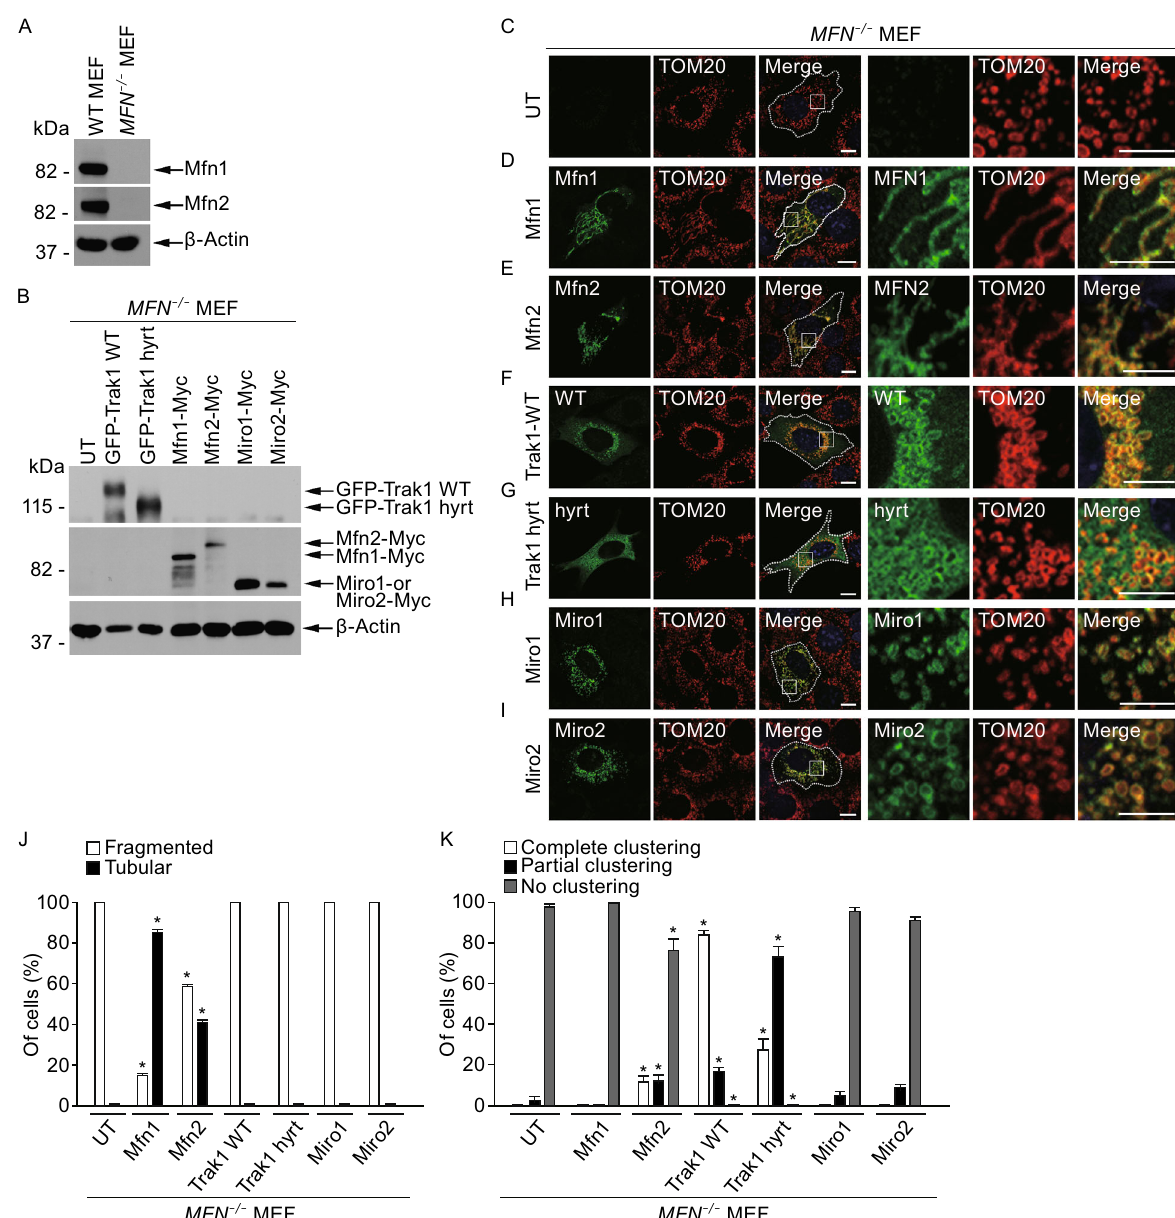
Figure 8. Trak1 overexpression causes mitochondrial clustering in mitofusin-de fi cient cells. (A) Western blot analysis of cell lysatesfromwild-type(WT)and MFN − / − MEFswithanti-Mfn1andanti-Mfn2antibodiesshowsthelackofbothMfn1andMfn2proteinsin MFN − / − MEFs. Anti- β -actin immunoblotting was used as a loading control. (B) Western blot analysis of cell lysates from untransfected (UT)